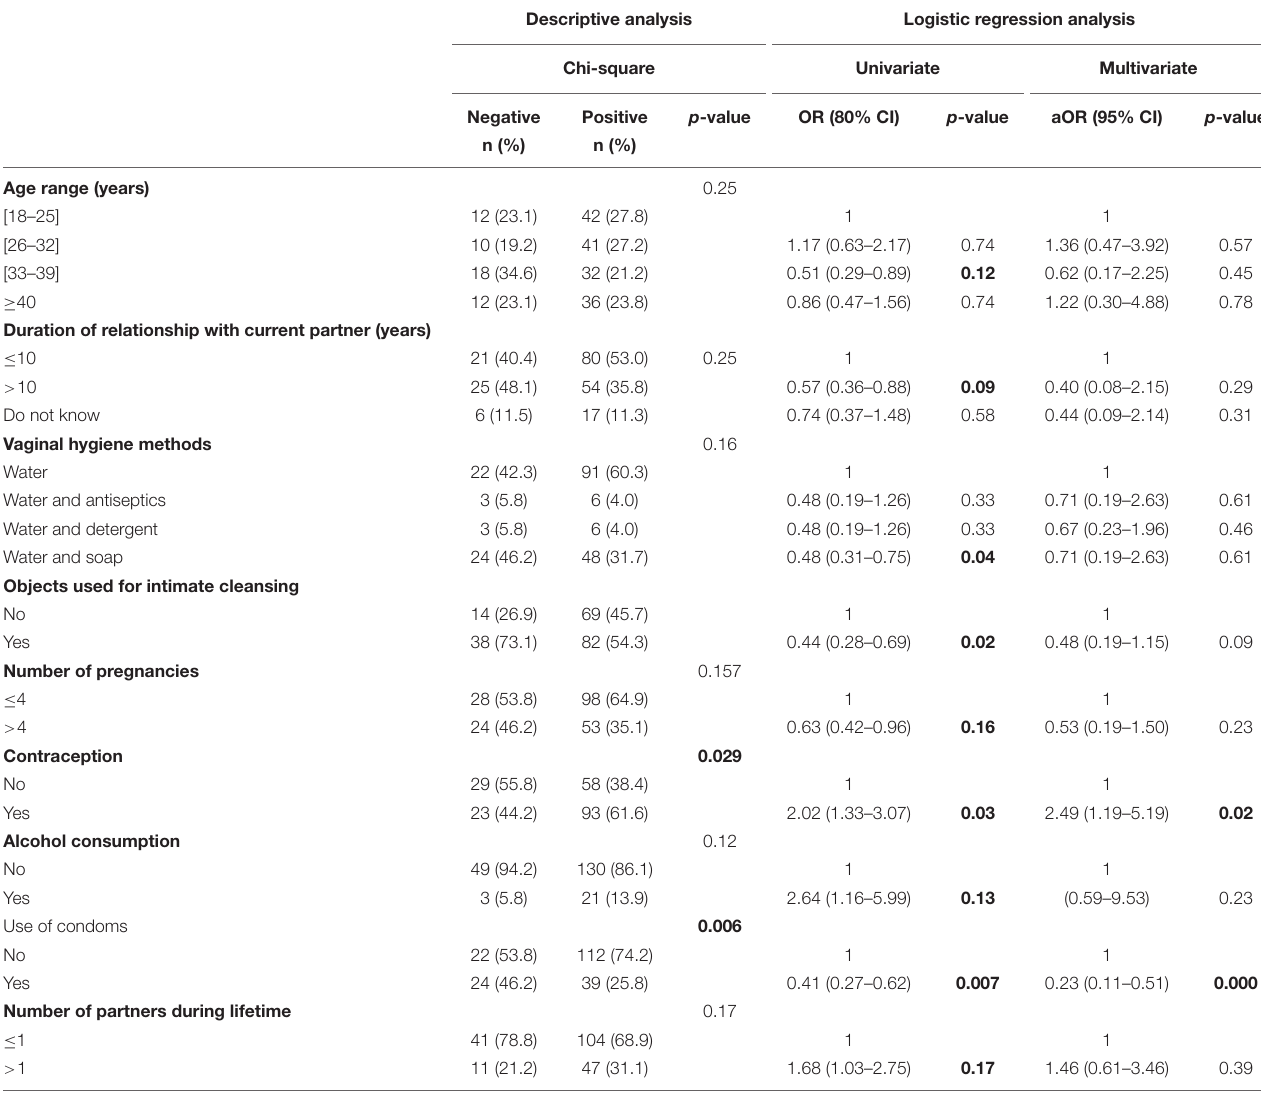
TABLE 2 | Descriptive and logistic regression analysis of factors associated with